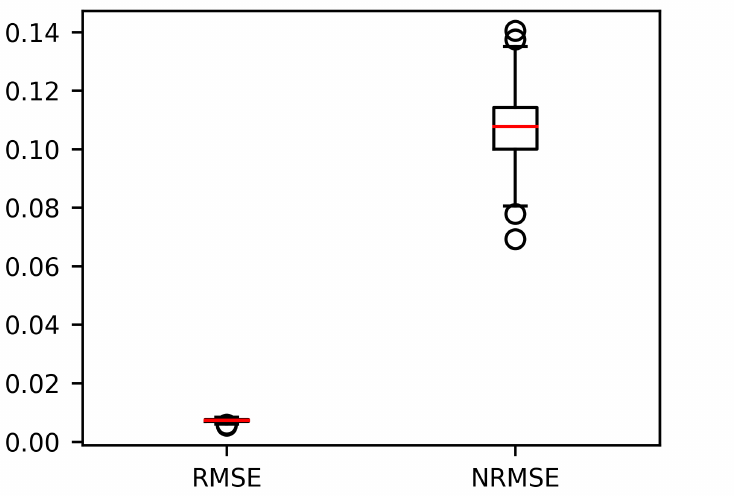
Figure 6. Box plot of the RMSE and the NRMSE of the in-sample fitting of the VARX models based on training set